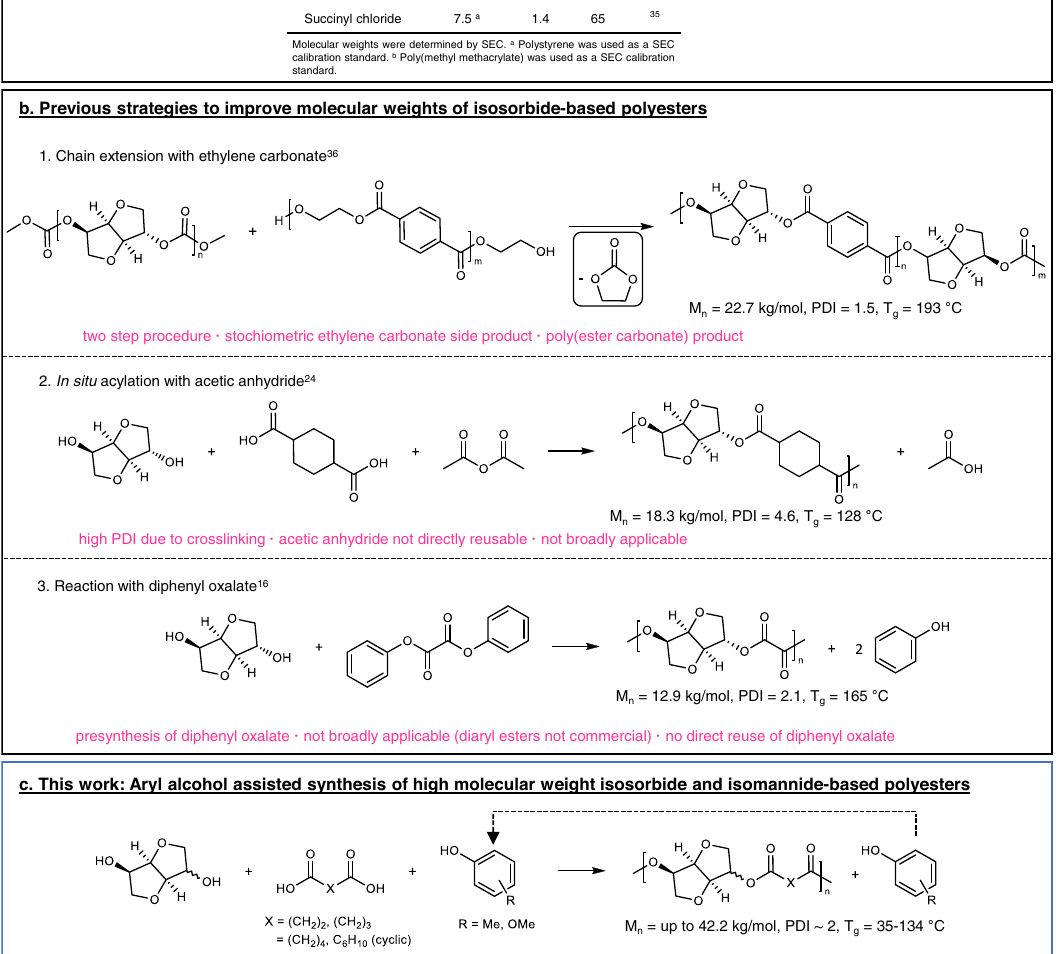
weights via silylation of isosorbide ’ s-OH groups and subsequent reaction with diacid chlorides. Please note that only one regioisomeric combination of iso- sorbide repeat units is depicted in the polymer structures. The chirality of isosorbidewillresultinapolymerwithanumberofpossiblearrangementsthat do not necessarily possess